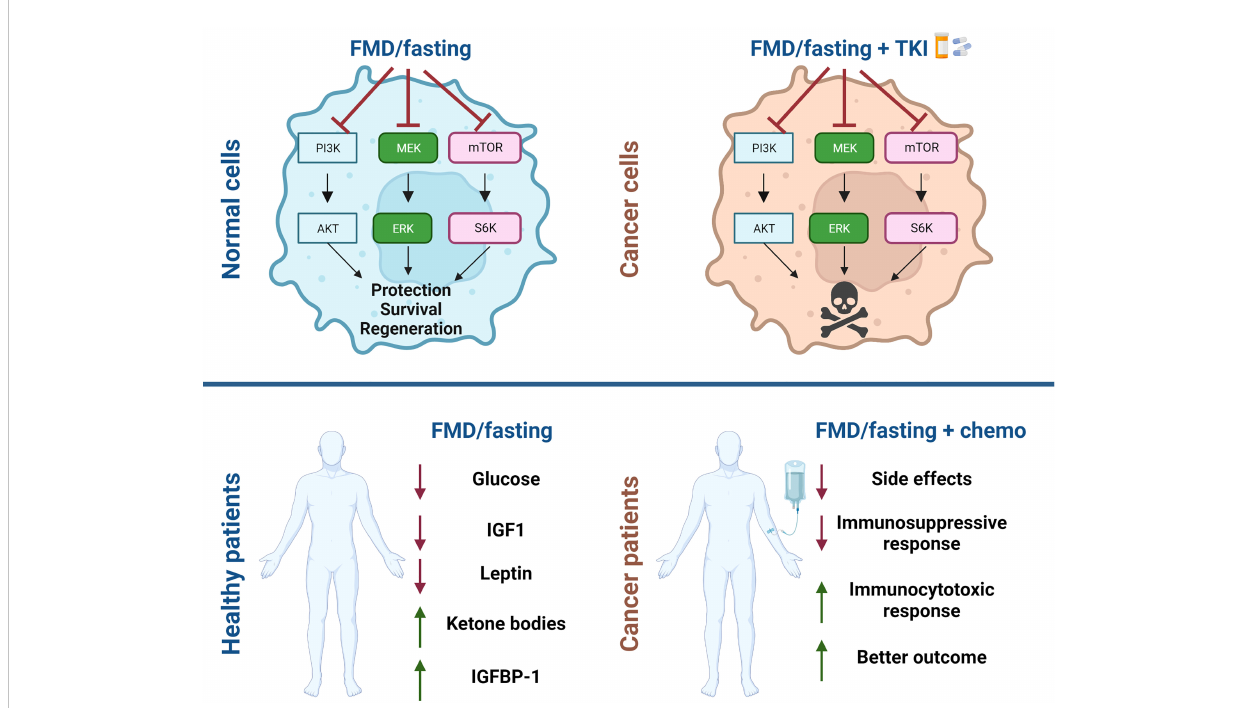
FIGURE 2 Schematic representation of bene fi cial effect of fasting and fasting mimicking diets for cancer treatment. Fasting and fasting mimicking diets (FMD) in combination with chemotherapy have a differential effect on normal cells and tumor cells. Normal cells enter in a protective mode while cancer cells are unable to survive. Systemic effects of fasting/FMD cycles are reduction in blood glucose, in circulating insulin growth factor-1 (IGF1) and leptin and increase in IGF1 binding protein-1 (IGFBP1) and serum ketone bodies. In combination with chemotherapy patients show fewer side effects, immunological changes and better outcomes. The fi gures were created with